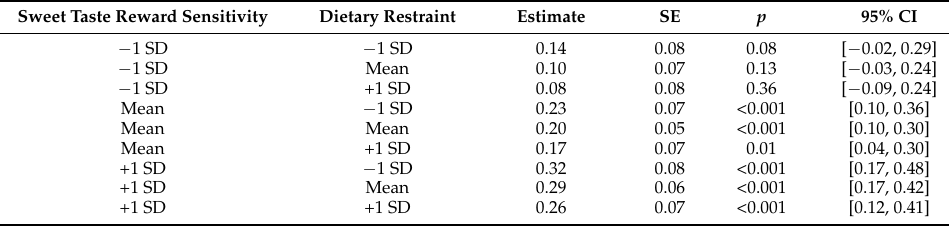
Figure 1. Interaction between body dissatisfaction and sweet taste reward sensitivity in relation to binge eating plotted at one standard deviation below the mean ( − 1 SD), mean, and one standard deviation above the mean (+1 SD) levels of sweet taste reward sensitivity. The three boxes indicate one deviation below the mean ( − 0.98), mean (0), and one standard deviation above the mean (0.98) levels of dietary restraint. Table 3. Conditional Effects of Body Dissatisfaction at Values of Sweet Taste Reward Sensitivity and Dietary Restraint.